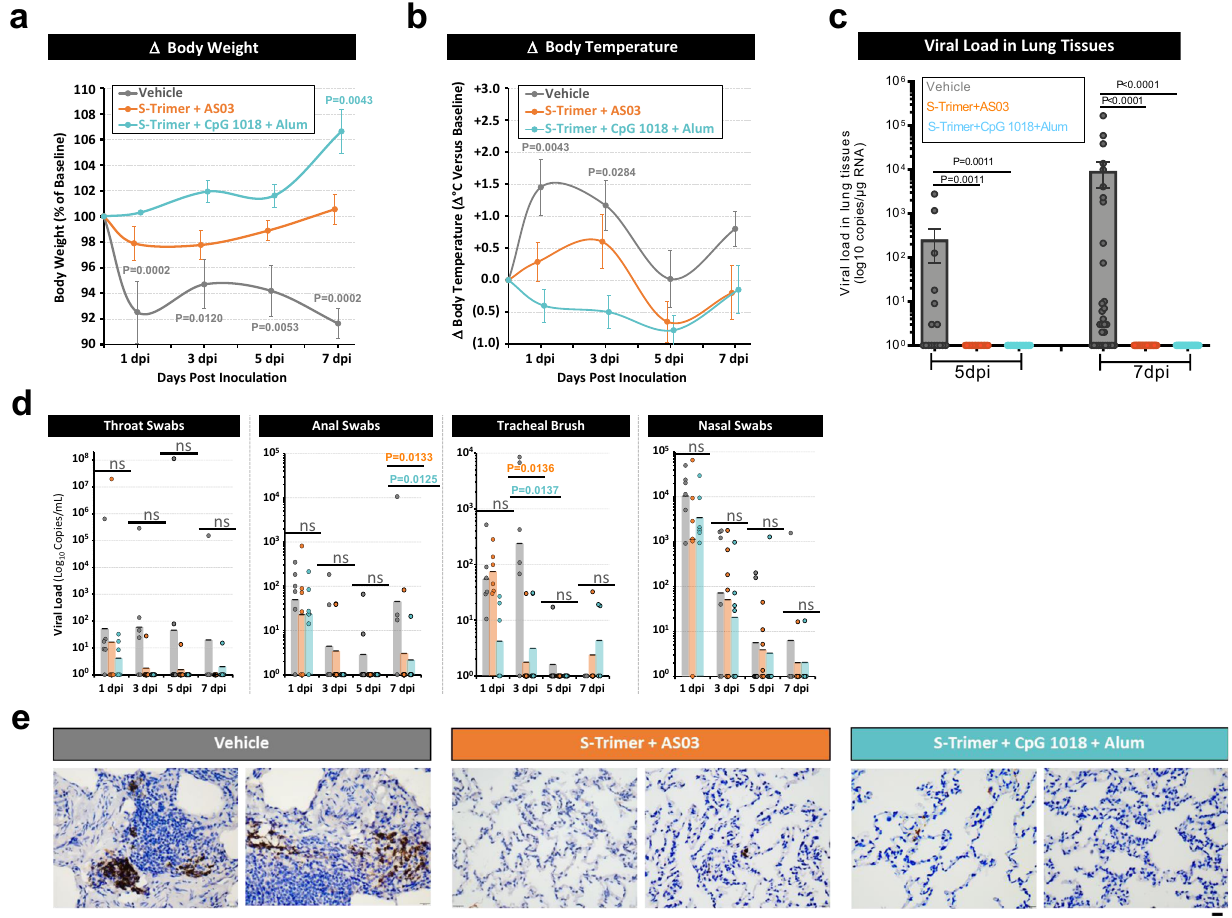
Fig. 5 Immune protection of S-Trimer against SARS-CoV-2 challenge in nonhuman primates. Rhesus macaques ( n = 6/group) were immunized with 30 µ g S-Trimer adjuvanted with 0.25 mL AS03, 30 µ g S-Trimer adjuvanted with 1.5 mg CpG 1018 plus 0.75 mg alum, or PBS vehicle control twice on Day 0 and Day 21 and were challenged on Day 35 with 2.6 × 10 6 TCID50 (60% intratracheal and 40% intranasal) live SARS-CoV-2 virus. Following SARS-CoV-2 challenge, clinical observation data were collected based on a changes in body weight and b changes in body temperature at 0, 1, 3, 5 ( n = 6) and 7 dpi ( n = 4). c At necropsy at 5 dpi ( n = 2 × 8 samples/group) and 7 dpi ( n = 4 × 8 samples/group), lung tissues were collected for measurement of viral loads based on genomic RNA (gRNA). d Throat swab, anal swab, tracheal brush, and nasal swab specimens at 1, 3, 5 ( n = 6) and 7 dpi ( n = 4) were collected for measurement of viral loads based on gRNA. Body weight and body temperature data are presented as mean values ± SEM. All viral load data are presented as geometric mean values± SEM. e Histopathological examinations in lungs from inoculated animals was conducted at necropsy. Lung tissues were collected and IHC staining with antibody speci fi c to SARS-CoV-2 Spike protein was conducted. Representative specimens are shown from two independent